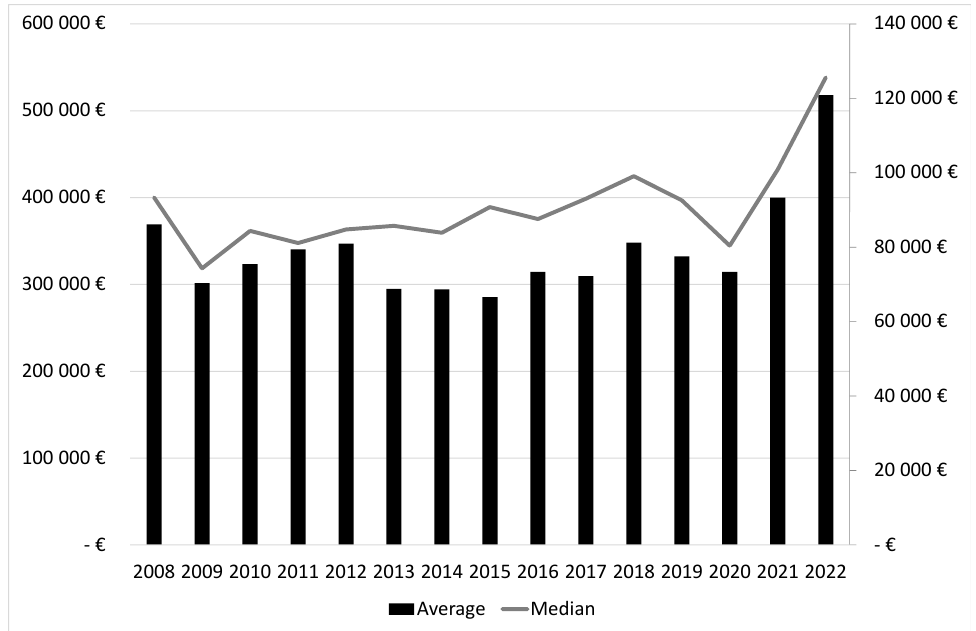
Figure 2. Absolute inventory amounts (in EUR) measured with average and median values within Finnish-stock-market-listed companies of manufacturing and trade during the period of 2008 – 2022 (the last year 2022 only consisted of data from the first half of the year). The y-axis on the left side is for the average, and the y-axis on the right-side is for the median series. Upper (75%) and lower (25%) quartile curves also illustrate consistency in inventory investment growth (Figure 3), as did the median and average numbers. Apart from the changes of 2008 – 2009, growth in inventory investments seem to be continuous, and in the year 2020, there was a rather minor decline in the upper quartile ( − 5.3 decline in 2020 from 2019), while the lower quartile still continued to grow (21.2% growth in 2020 from 2019). Growth was substantial in both the years 2021 and 2022. The lower quartile growth (63% growth from 2020 to 2022) was similar to the average and median values; however, the upper quartile showed a much more significant change, with a growth of 89%.